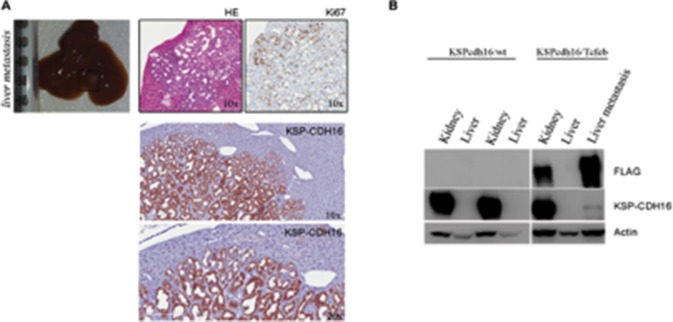
DOI:
http://dx.doi.org/10.7554/eLife.17047.024